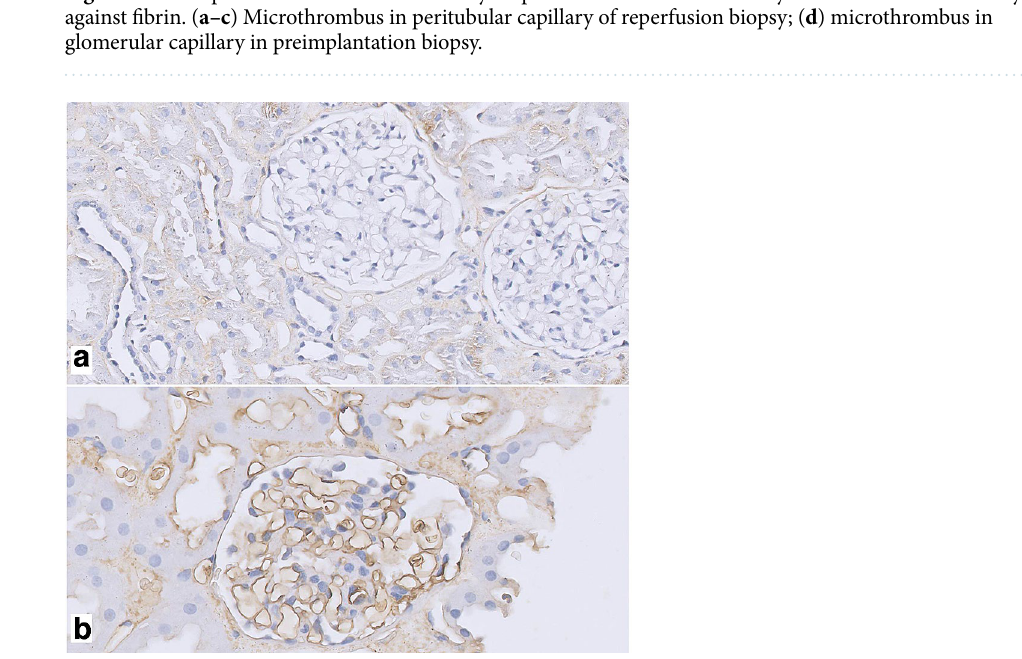
Figure 2. Fibrin stain intensity differences of the glomerular and PTC endothelium between preimplantation and reperfusion biopsies (IHC stain). (a) Example of the most observed intensity in preimplantation biopsies ( ×40 magnification); (b) example of most observed intensity in reperfusion biopsies (×60